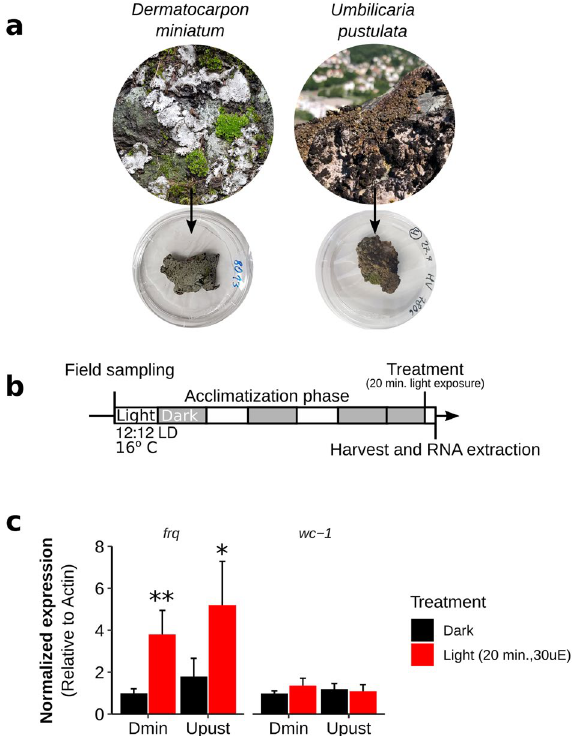
Figure 2. Homologs of frq in two lichen-forming fungi are responsive to light. ( a ) Thalli of the lichen-forming fungi Dermatocarpon miniatum and Umbilicaria pustulata, harvested in the Taunus mountain range of central Germany. ( b ) Lichen thalli were acclimatized to standard laboratory conditions via a 72 h LD 12:12 cycle at 16° C before 24 h in constant darkness, followed by a 20-min light induction at CT 0. ( c ) RT-qPCR analysis demonstrates broad conservation of light responsiveness in the circadian clock components of lichen-forming fungi. n = 6 for Dmin, n = 5 for Upust per treatment; mean ± SEM are shown. Asterisks represent significance extracted using Šidàk-adjusted contrasts: * P < 0.05; ** P < 0.01; *** P < 0.001. Dmin: Dermatocarpon miniatum ; Upust: Umbilicaria pustulata ; frq: frequency; wc-1: white